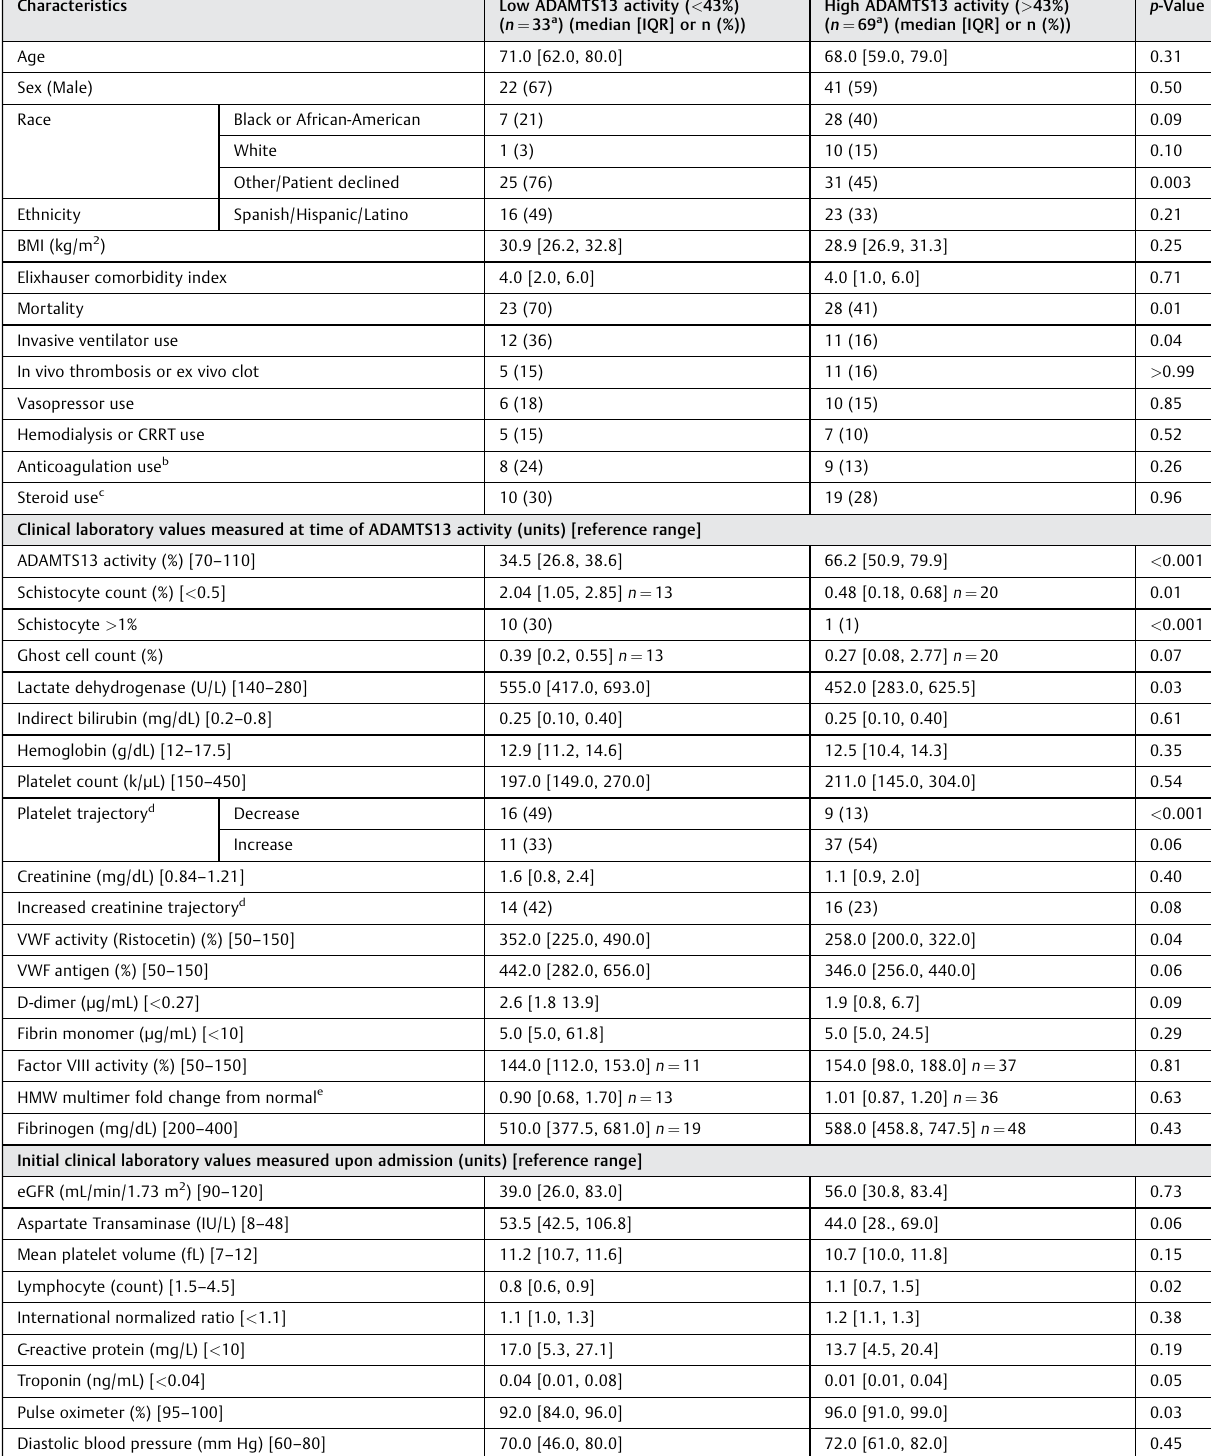
Table 3 Clinicallaboratorydatawithin the fi rst72hours ofadmissionfrompatientswithCOVID-19strati fi edbyADAMTS13activitylevel